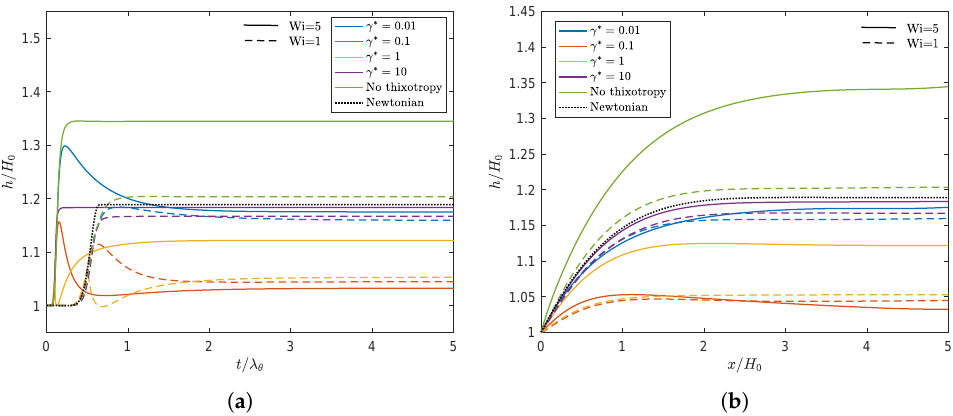
Figure 16. Swell ratio as a function of dimensionless time for the point of the free surface on Γ out ( a ) and final swell ratio of the free surface as a function of the x -coordinate along the free surface ( b ). Here, x / H 0 = 0 corresponds to the x -coordinate at the die exit. Results are obtained for different values of γ ∗ for the rate-controlled approach using two different Weissenberg numbers. Solid lines indicate the results for Wi = 5, whereas dashed lines indicate the results for Wi =